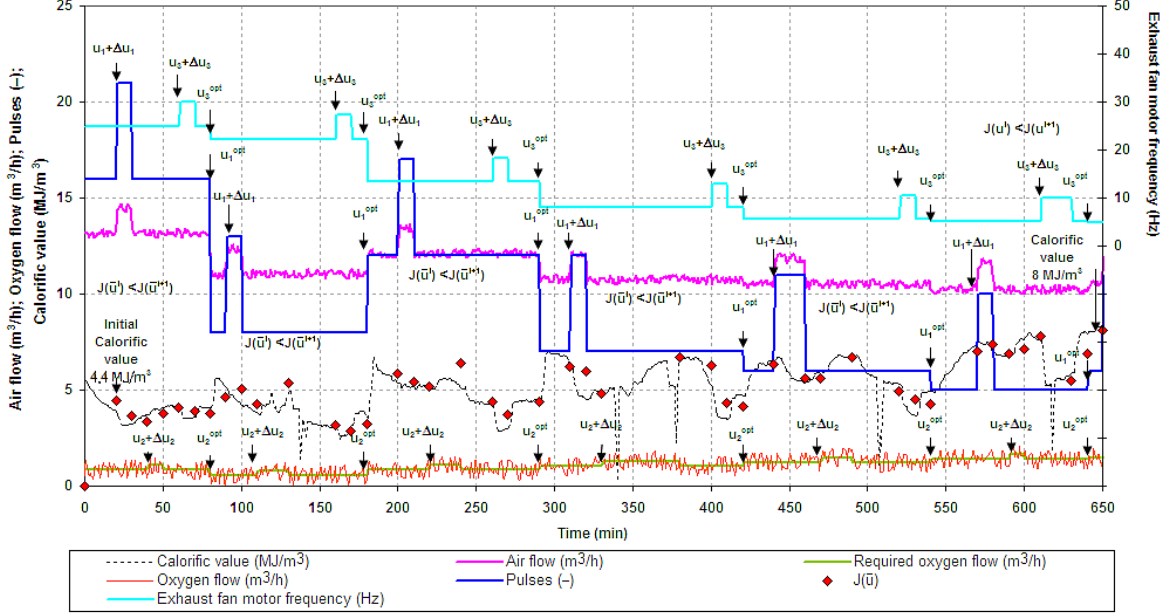
Figure 16. Maximization of syngas calorific value via optimization of three manipulation variables of UCG [31].